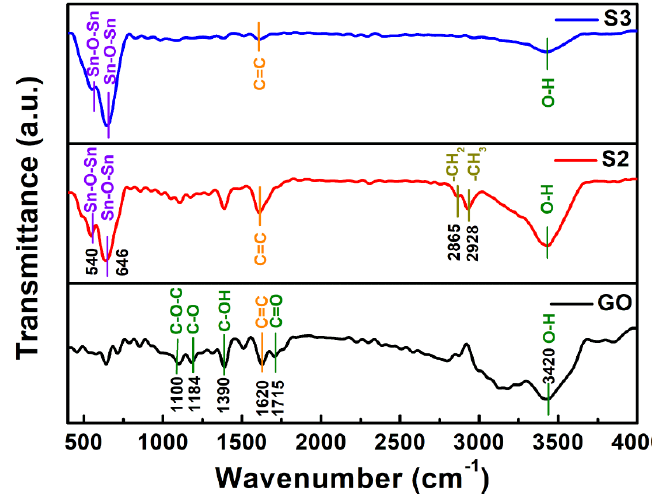
Figure 3. FTIR spectra of GO, S2, and S3.